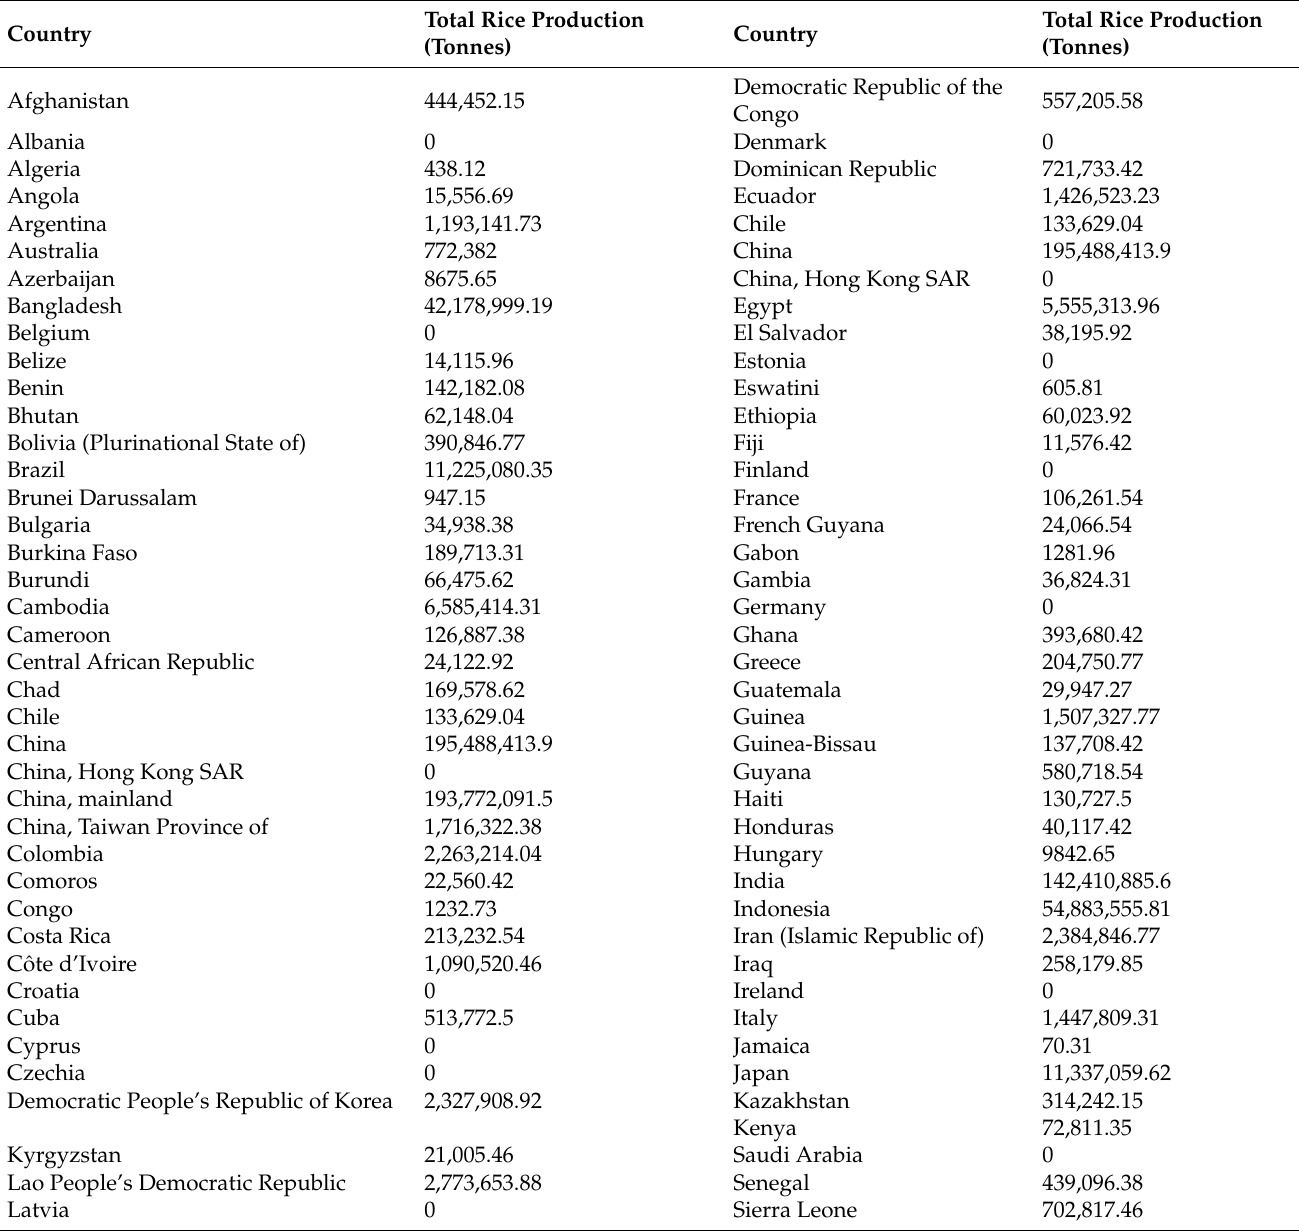
Table 2. Production quantities of rice by country worldwide in 2019